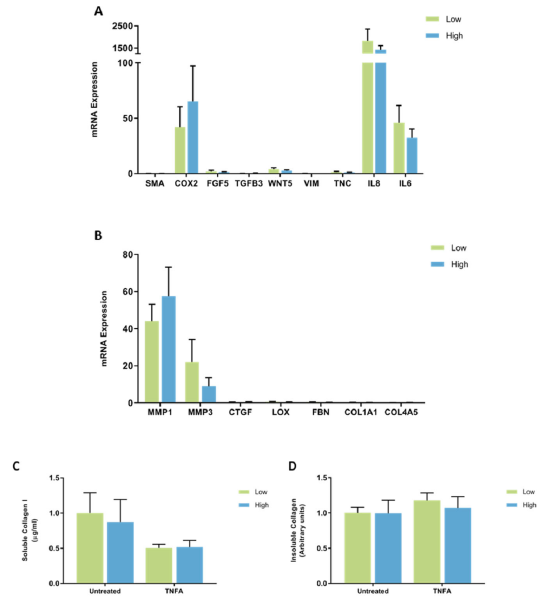
Figure 11. The effect of TNFA on mRNA expression and collagen production in mammary fibroblasts isolated from women with high and low mammographic density. Messenger RNA expression of cancer-associated genes ( A ) and genes involved in extracellular matrix regulation and collagen production ( B ) measured by RT-PCR in human mammary fibroblasts from women with high ( n = 7) and low ( n = 9) mammographic density following treatment with 10 ng/mL of TNFA for 72 h. mRNA expression normalised to HPRT1 expression and presented as relative expression where the average for untreated control is 1. Collagen production was measured using collagen 1 ELISA ( C ) and insoluble collagen measured by sirius red staining ( D ). Data presented as mean + SEM with statistical analysis performed using a linear mixed-effects model Tukey’s post hoc